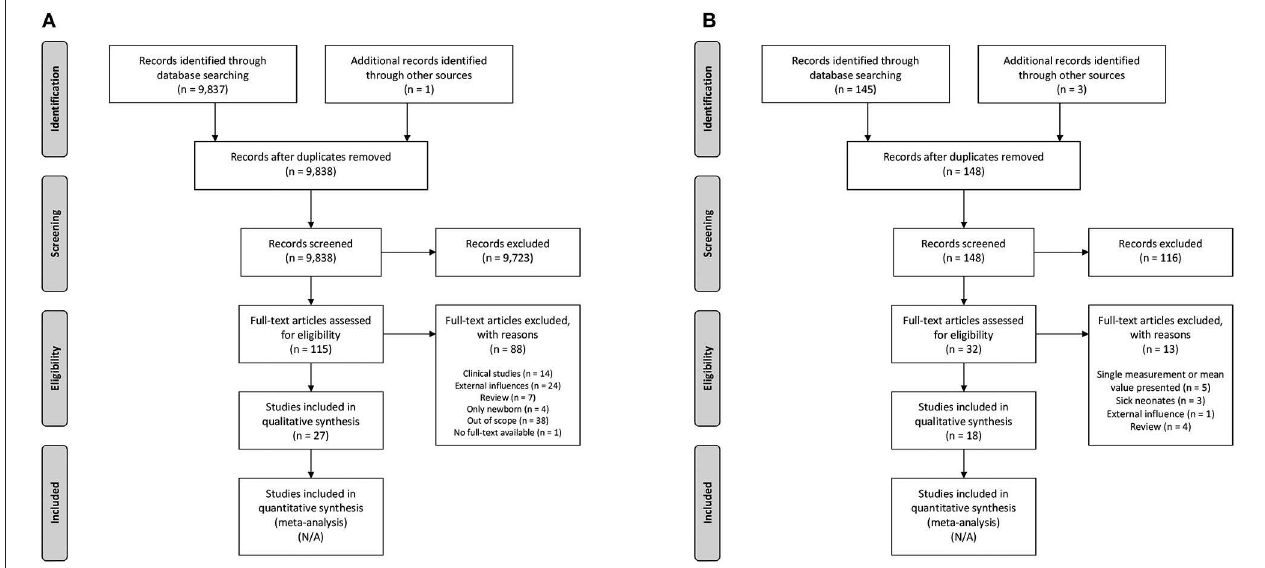
FIGURE 2 | Search strategy. (A) Postnatal maturation of intestinal oxygenation mechanisms, (B) Clinical observations. N/A, not applicable.